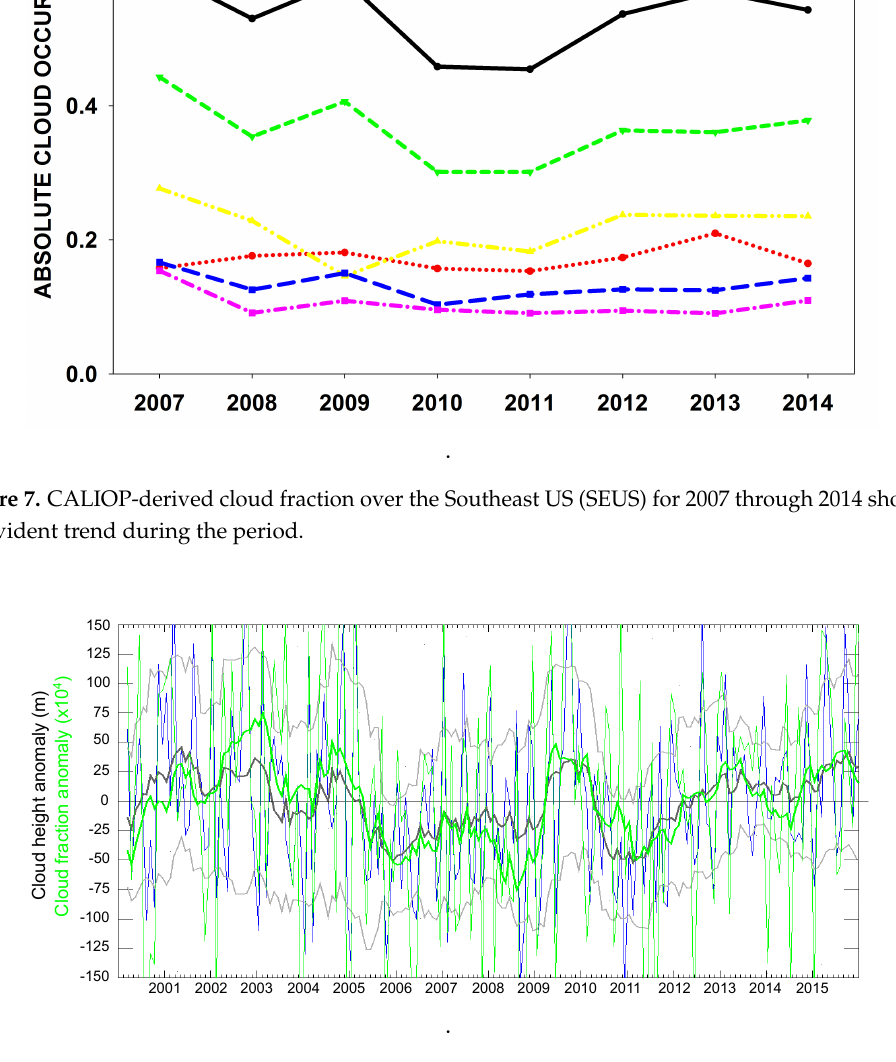
Figure 8. MISR-derived monthly cloud fraction over the Southeast US (SEUS) for March 2000 through 2015 showing no evident trend during the period. The thick gray line represents the anomaly in the mean cloud height smoothed with a 12-month running mean. The actual data are in blue and the gray lines indicate the 1-sigma bounds. The thick green line is the cloud fraction